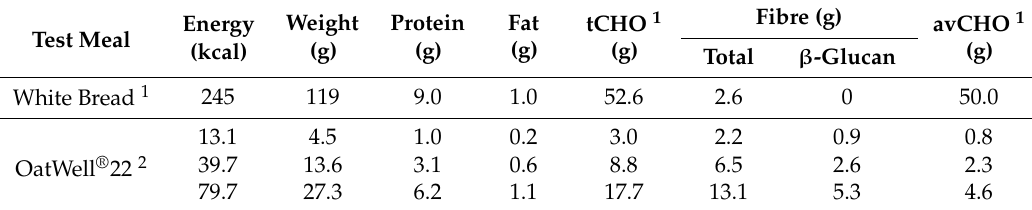
Table 1. Nutrient content of test meal